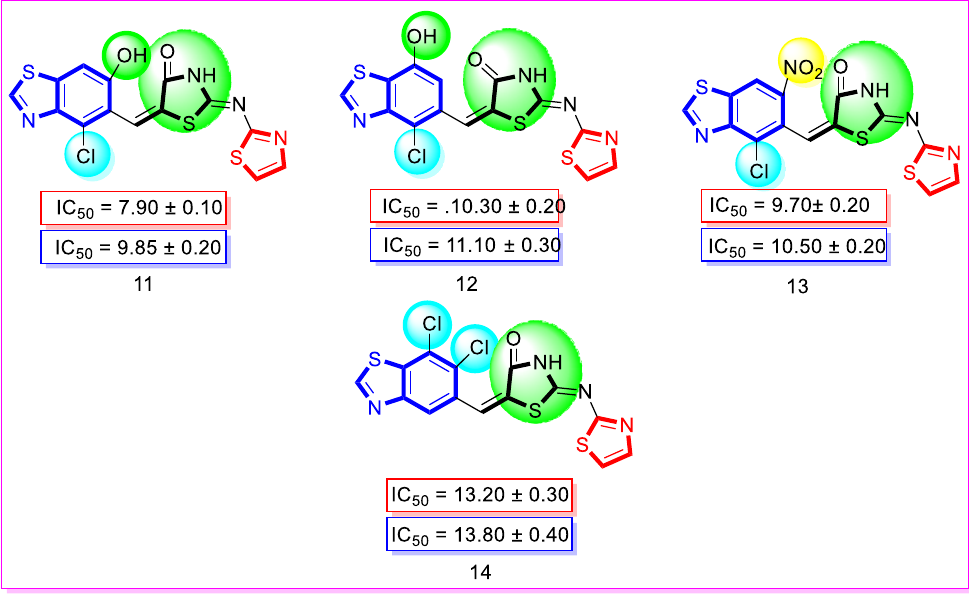
Figure 6. SAR study of analogues 11 , 12 , 13 , and 14 . Some of the screened analogues were found with moderate to the least potential against both α - amylase and α -glucosidase enzymes. When compared with the standard drug acarbose (10.20 ± 0.10 and 11.70 ± 0.10), these analogues displayed a varied range of inhibitory profiles in both activities, such as analogues 9 (21.50 ± 0.30 and 23.20 ± 0.40), 10 (23.20 ± 0.10 and 24.60 ± 0.20), and 15 (27.50 ± 0.70 and 28.40 ± 0.80). The moderate